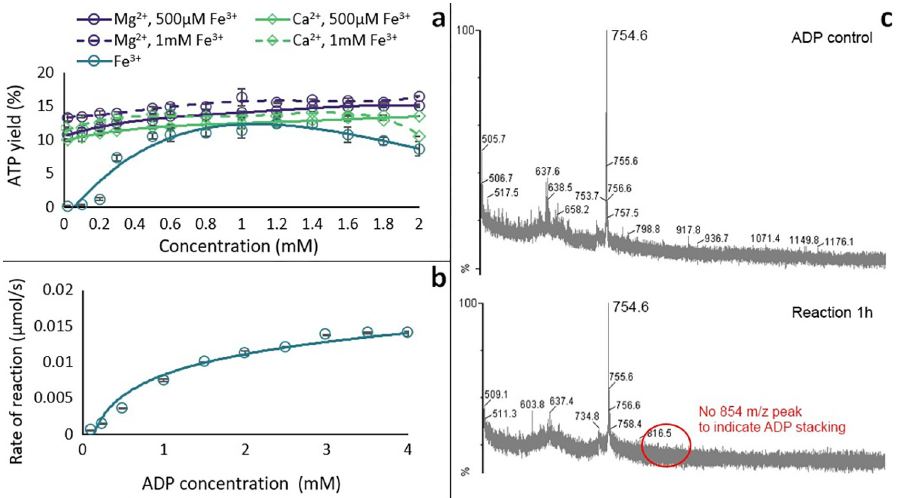
Fig 5. Mechanism studies. ( a ) Effect of varying concentration of Fe 3+ (teal circles) and adding increasing concentrations of Mg 2+ (purple circles) and Ca 2+ (green diamonds) on ATP yield at 2 h from the reaction ADP (1 mM) + AcP (4 mM) with 0.5 mM Fe 3+ (solid line) and 1 mM Fe 3+ (broken line) at 30˚C and pH approximately 5.5–6. ( N = 3 ± SD and 2 ± SD, respectively). ( b ) Michaelis–Menten kinetic analysis on the ADP + AcP reaction catalysed by Fe 3+ (0.5 mM). N = 3 ± SD. ( c ) MALDI-ToF spectra of ADP control (top) and a reaction sample at 1 h (bottom). The data underlying this figure can be found in Table T and U and Fig A in S1 Data (sheet 5).